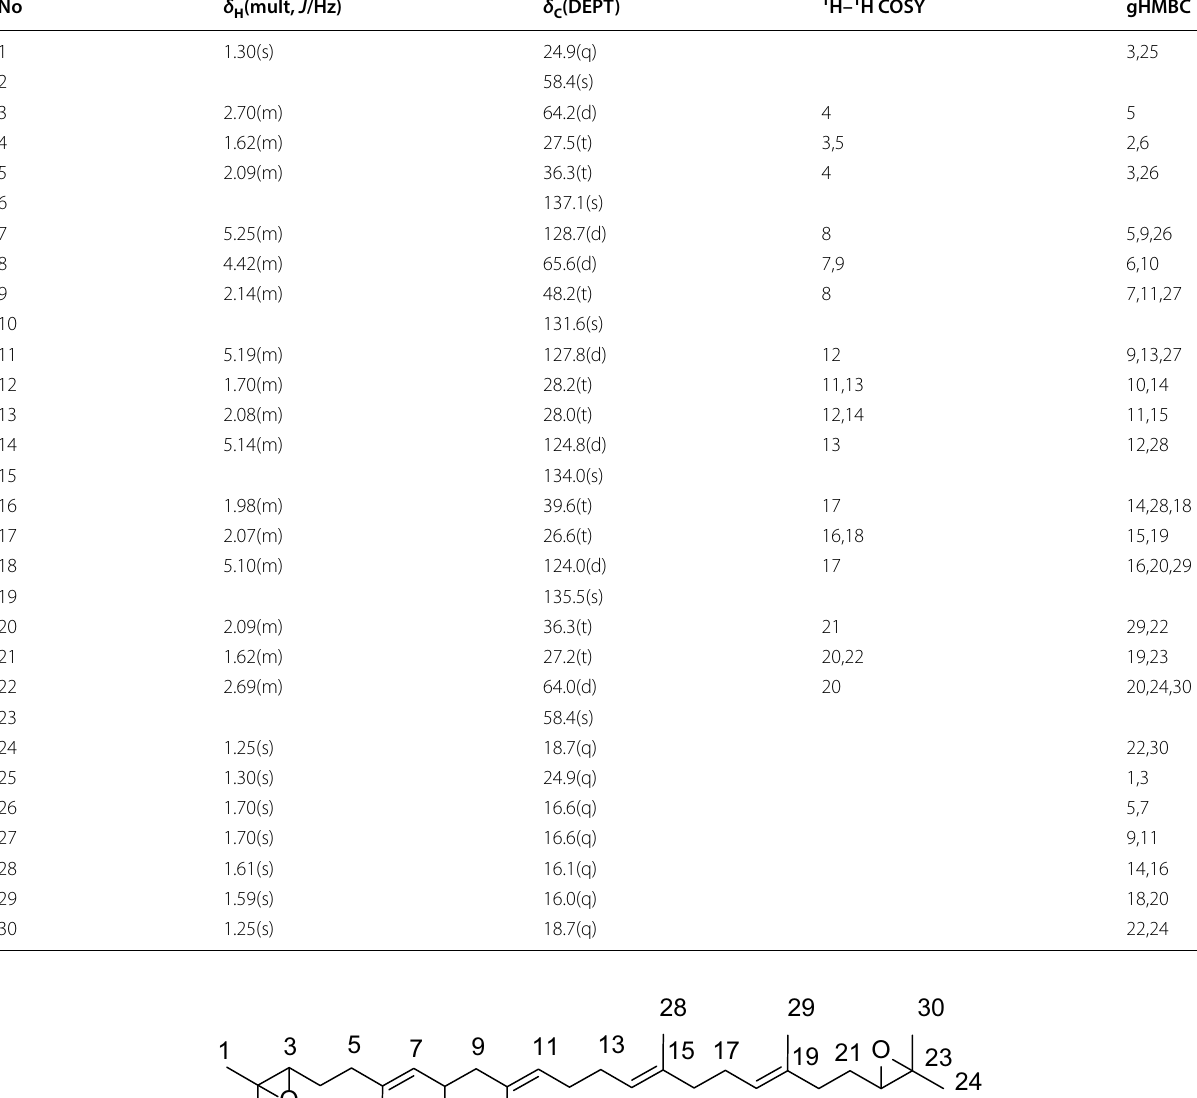
Table 2 NMR data of